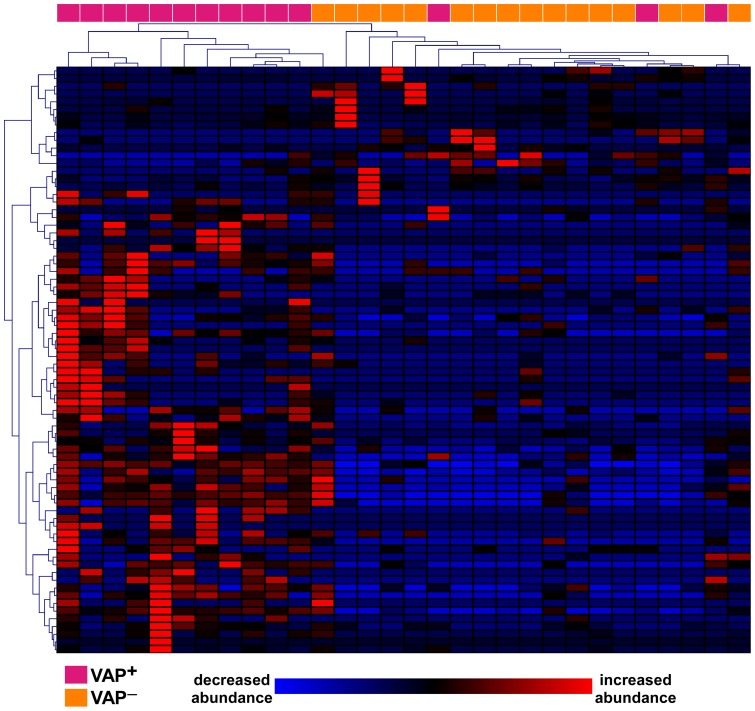
Two-dimensional hierarchical clustering of ALI patients based on the profiles of differentially expressed proteins.This unsupervised methodology demonstrates that relative abundances of 75 BALF proteins can reasonably discriminate patients with VAP from those without it.